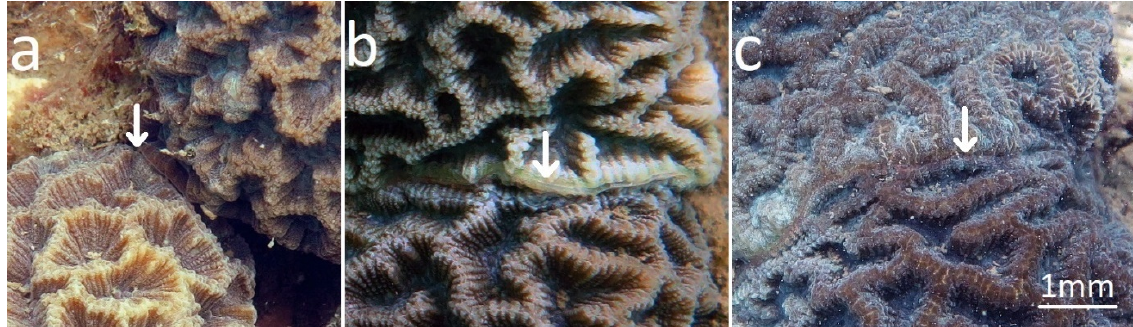
Figure 3. Fragments of Platygyra sinensis exhibiting responses associated with nonfusion, indicated by arrows. ( a ) Neither tissue rejection nor mortality was observed upon contact at Month 3; ( b ) nonfusion and raised suture formation between two fragments at Month 8; ( c ) overgrowth of the top transplant over the bottom observed at Month 15.